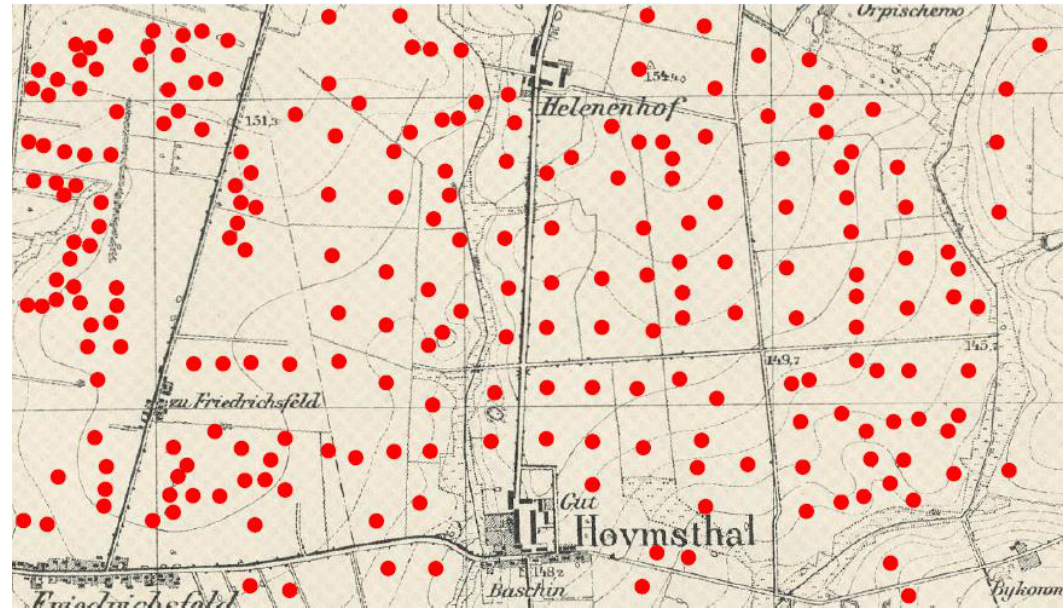
Figure 4: Distribution of PMH – an example from the surroundings of Baszyny (Hoymsthal) village (PMH are marked in